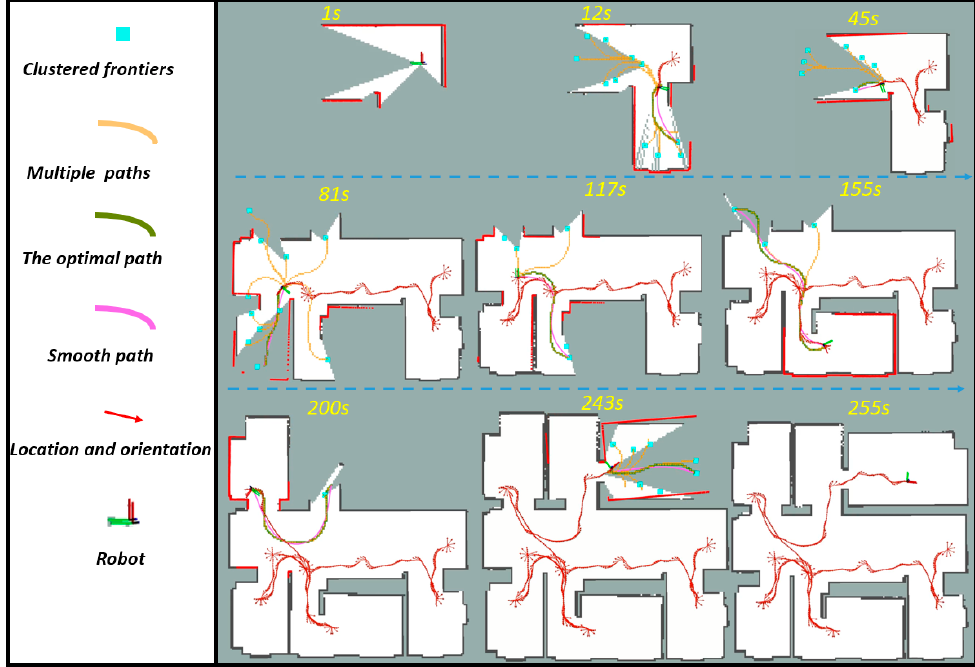
Figure 7. The autonomous exploration process of the robot in the lab environment.